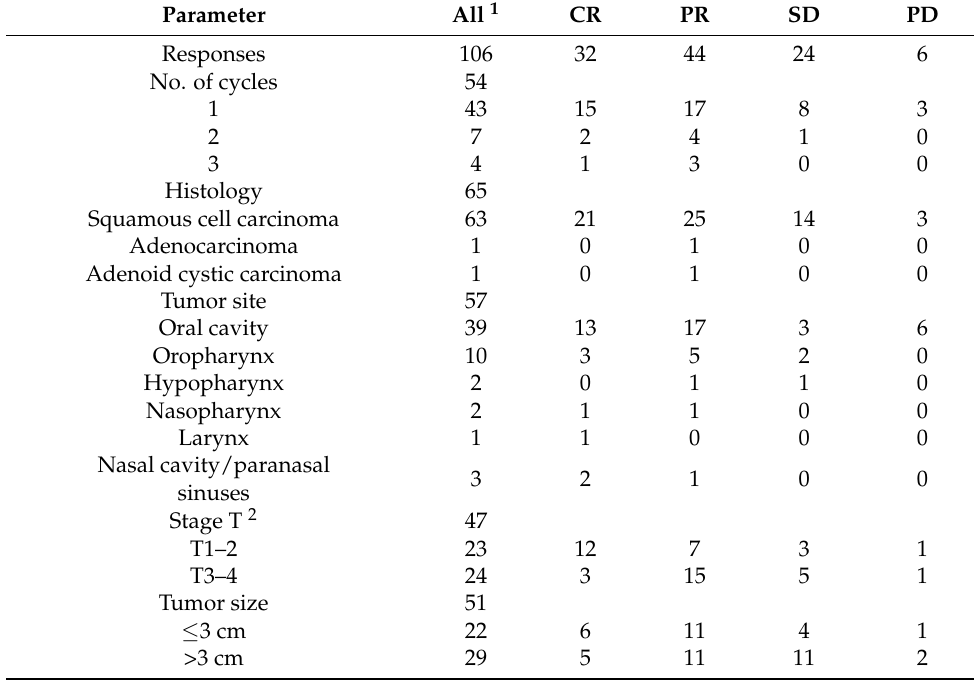
Table 4. Palliative electrochemotherapy: tumor